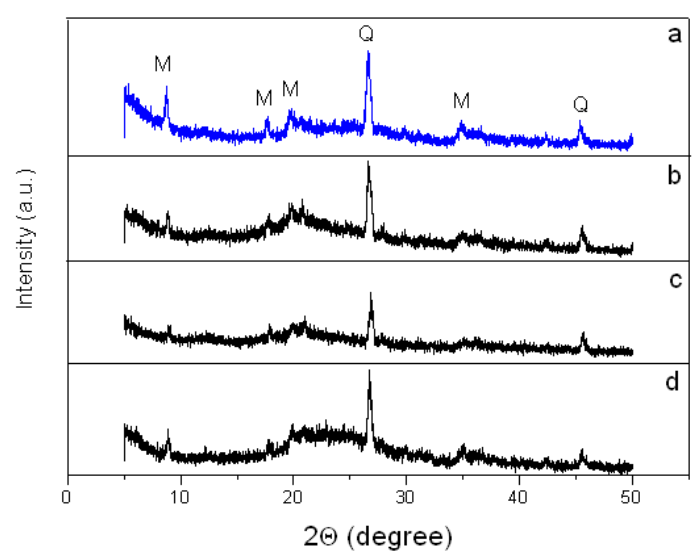
Figure 5. X-ray di ff raction (XRD) patterns for MMT K10 ( a ), MMT K10 / BMImOTf ( b ), Figure 5. X-ray diffraction (XRD) patterns for MMT K10 ( a ), MMT K10/BMImOTf ( b ), MMT Table 1. Results of X-ray spectral analysis for MMT K10 and MMT K10 / IL